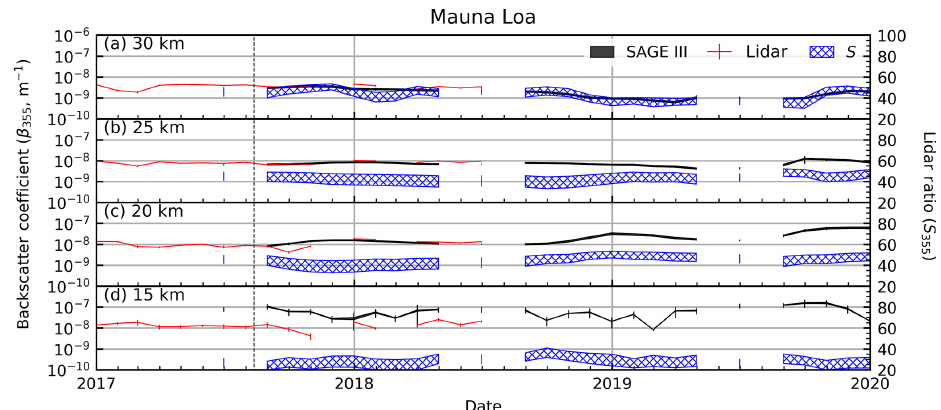
Figure 9. Same as Fig. 8, but for SAGE III. Vertical dashed line indicates the 2017 pyroCB event.